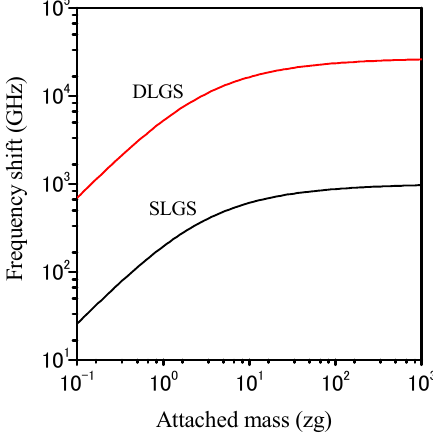
Figure 5. Comparison of the frequency shift for DLGSs- and SLGSs-based on mass sensor ( (cid:1838) 2ℎ = (cid:1838) 2ℎ = 20, (cid:2022) = (cid:2015) = 0.5⁄⁄ ). (cid:3028) (cid:3029)